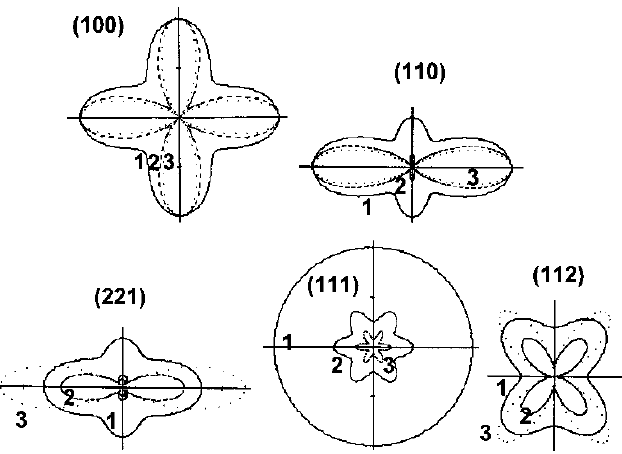
FIGURE 2 Polar plots (in arbitrary units) of functions H 2 (full lines), H 4 (broken lines) and H 6 (dotted lines) in various cross-sectional planes as indicated in figures. The factor of amplification for functions H 6 with respect to function H 2 (or to function H 4 ) was adjusted to 2.5 for (112) and (221) cross-sections in order to distinguish more easily the secondary extrema in the H 6